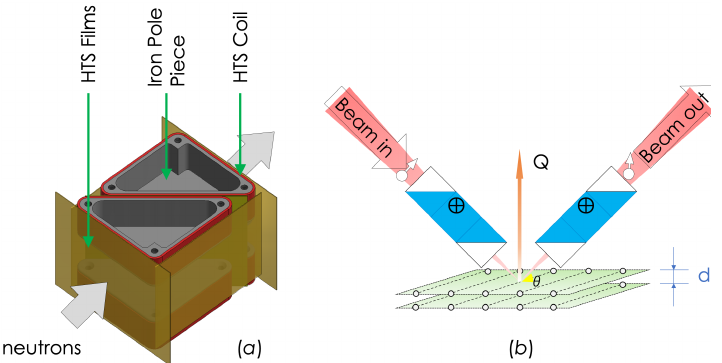
Figure 3. ( a ): Neutron Wollaston prism. ( b ): Pair of such prisms with additional rectangular field regions in-between. This particular configuration of two MWPs can measure the d -spacing between crystal planes with very high ( ∼ 10 − 6 ) relative